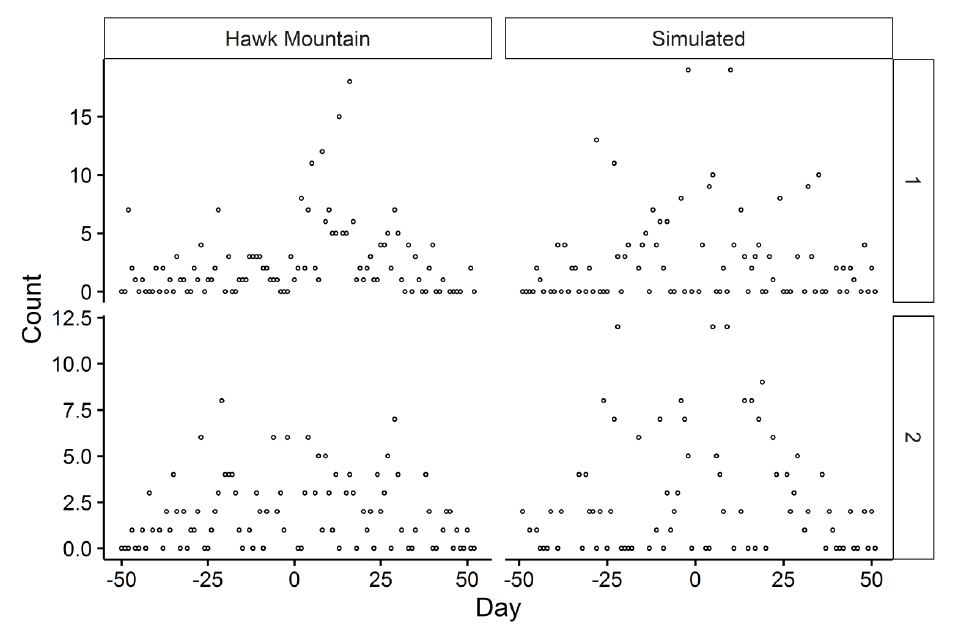
Figure A3.1. Example distribution of real and simulated daily migration counts for a commonly detected species (Northern Harrier). Real migration counts were collected at Hawk Mountain Sanctuary, Pennsylvania in 2000 (year 1, top panel) and 2001 (year 2, bottom